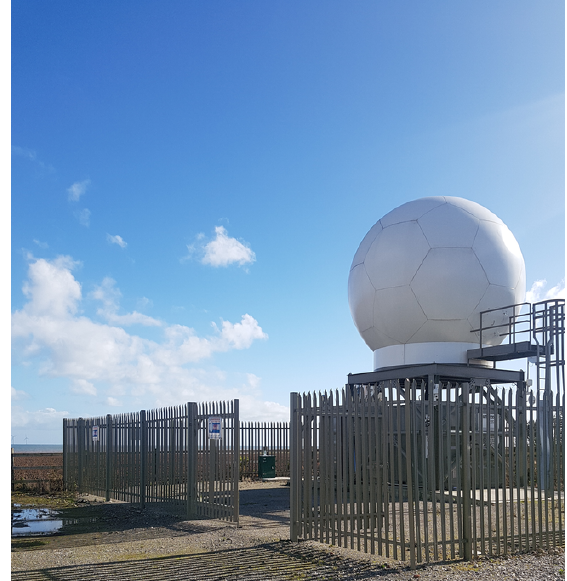
Figure 6. One of the two Doppler radar units deployed for the BEACon project